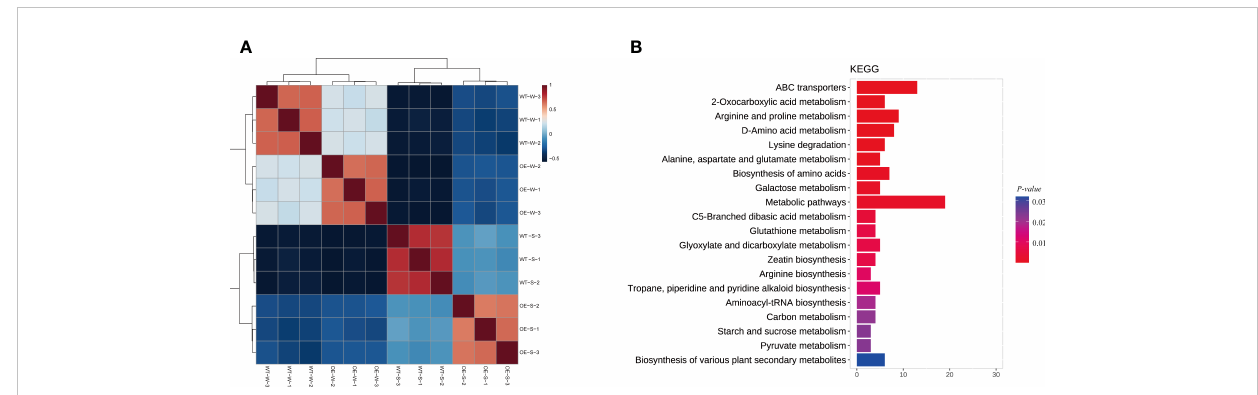
FIGURE 5 Metabolic pro fi les between water and saline-alkali treated AhALDH3H1 transgenic soybean. (A) Pearson correlation among QC samples. Red and blue colors indicate high and low correlation, respectively. (B) KEGG analysis of signi fi cant DAMs. The y-axis represents KEGG pathways; the x-axis indicates gene numbers. Colors from blue to red indicate decreasing P value.